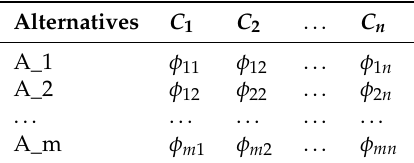
Table 1. Final decision